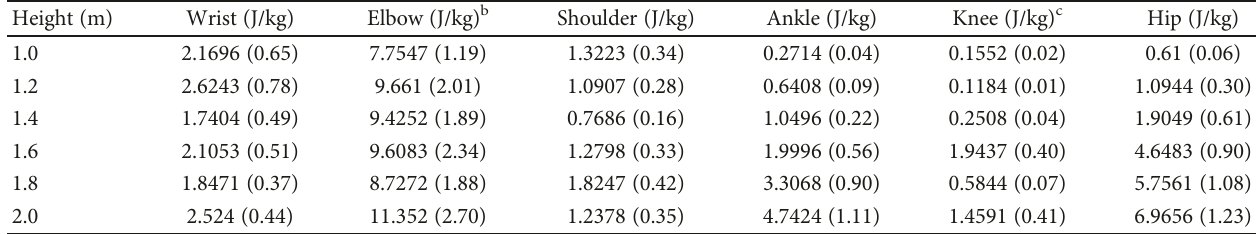
Table 4: Mean and SD of energy absorbed by the RF and RH limb joints across all jump heights a . Height (m) Wrist (J/kg) Elbow (J/kg) b